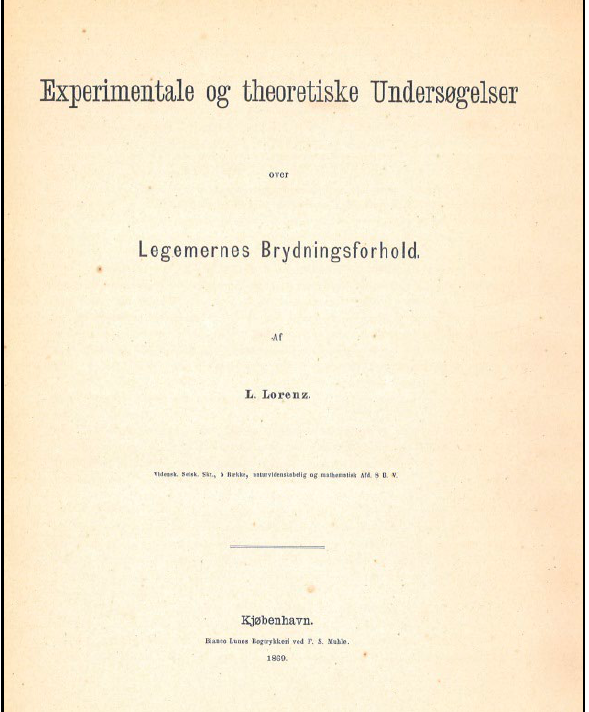
Figure 3. Lorenz’s 1869 memoir on “Experimental and Theoretical Investigations on the Refractivity of Substances” published by the Royal Danish Academy of Sciences and